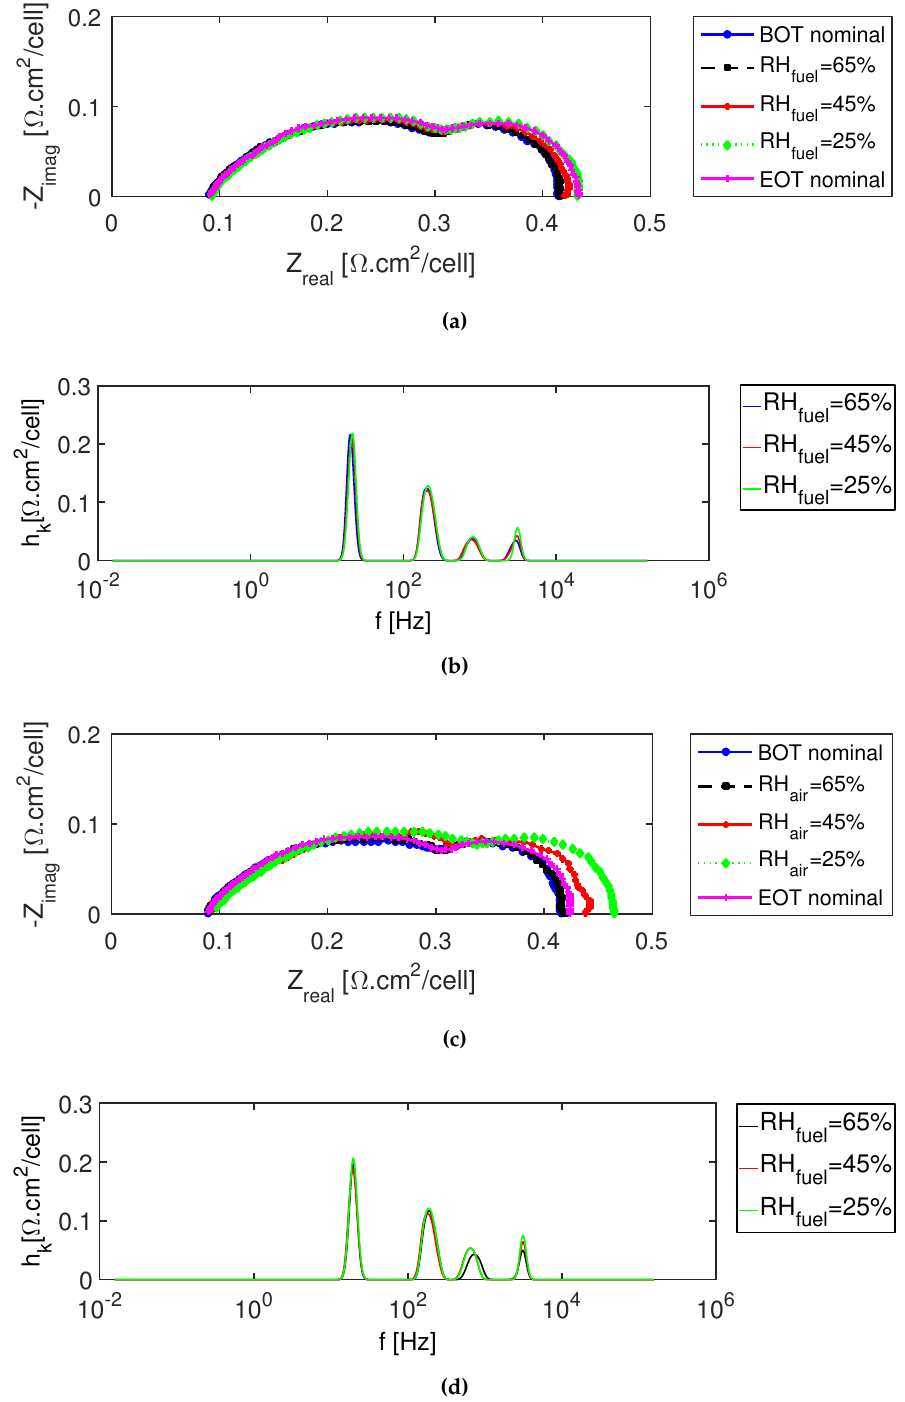
Figure 5. Drying at 40 A: ( a ) anode drying EIS spectra; ( b ) anode drying DRT analysis; ( c ) cathode drying EIS spectra; ( d ) cathode drying DRT